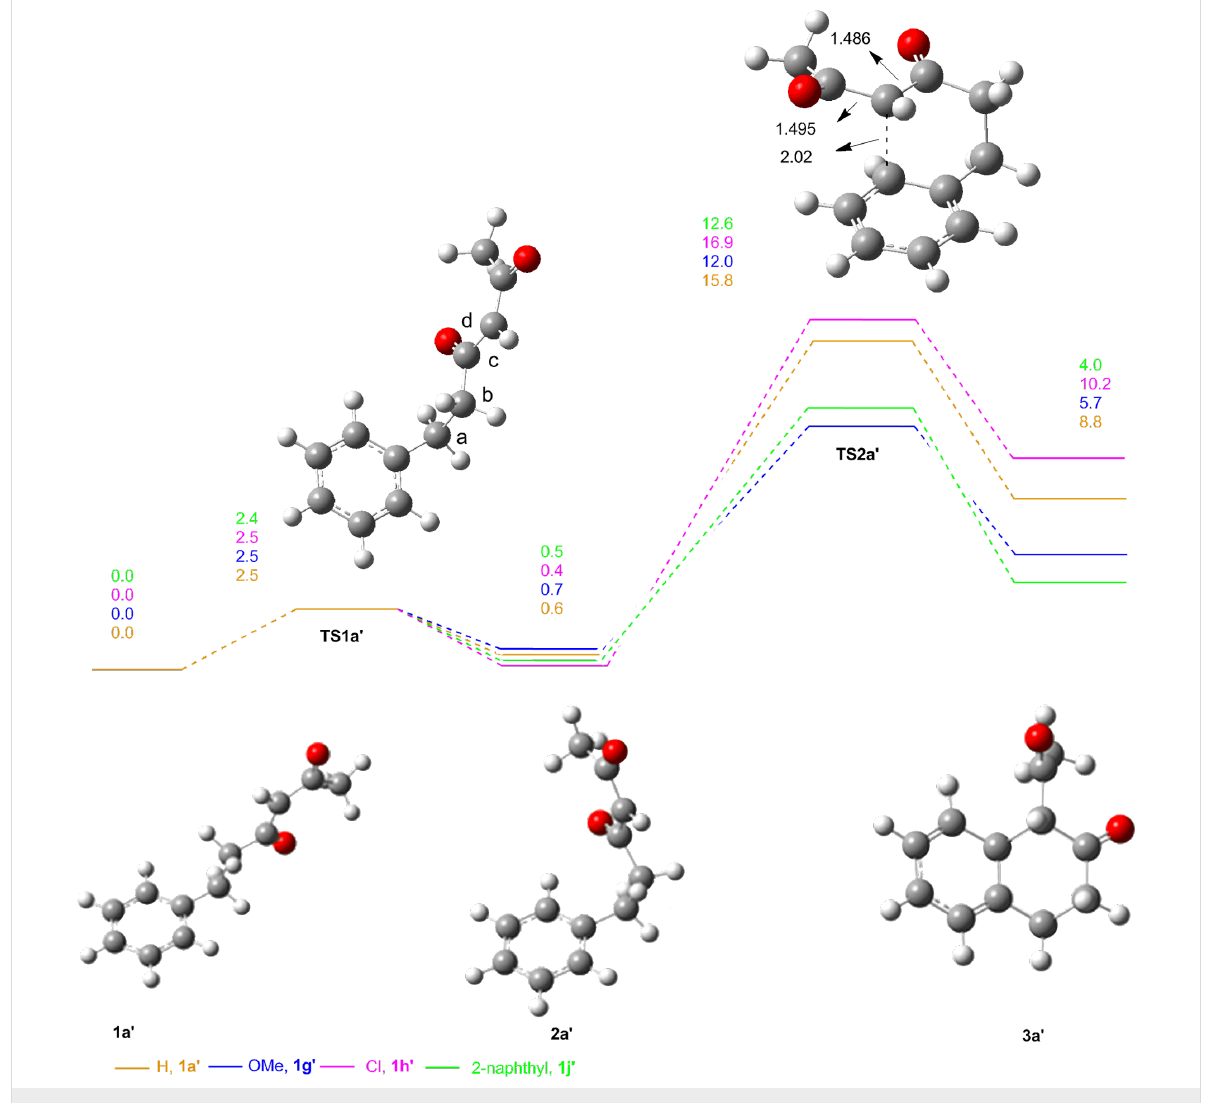
Figure 1: Energy diagram for the unsubstituted arene with the carbonyl groups anti to each other. For TS1a’ the dihedral angle between atoms abcd = 6.4°. * The energy values for 1a’ , 1g’ , 1h’ and 1j’ are shown. 1g” , 1f’ and 1j” were not included for clarity.